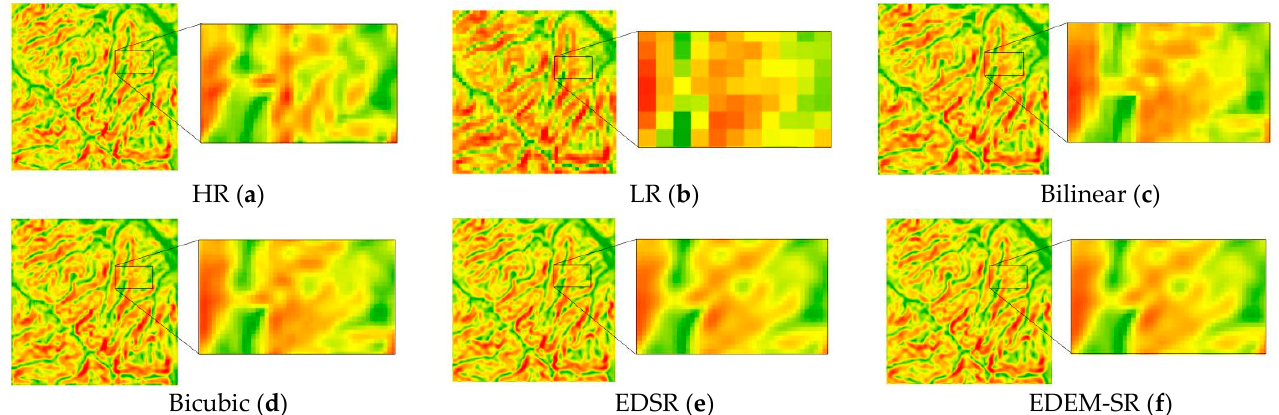
Figure 8. Example slope map visualizations with an up-scaling factor of 4.